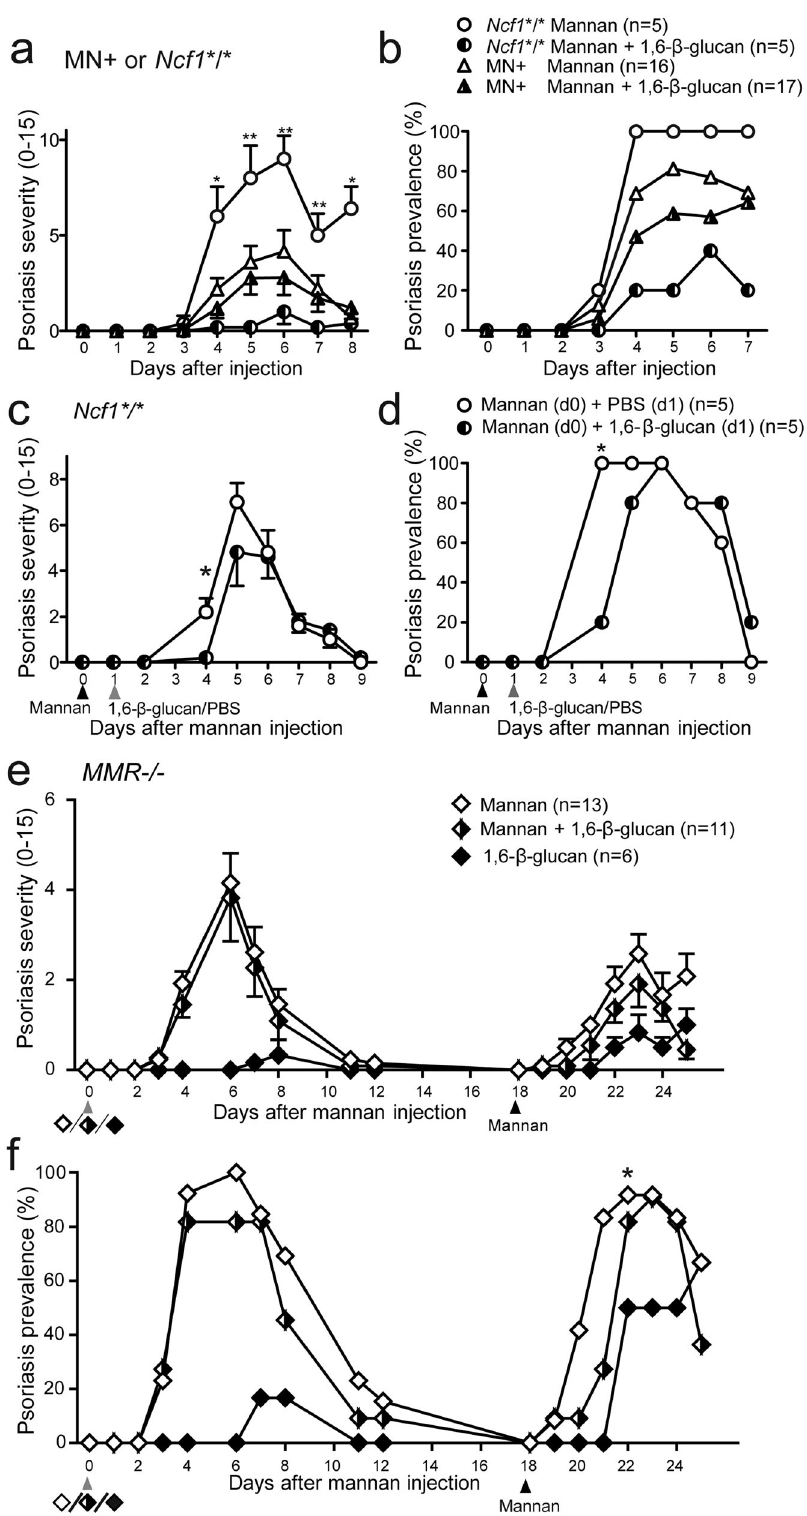
Exclusion was only done if the mice were suffering severe weight loss or exhibited other signs of poor well-being. Experiments were performed with 8 – 25 weeks old mice. Only naïve mice were used, no previous experiments have been performed on them. Polysaccharides . The polysaccharides used in the study are described in Table 1. Mannan (#M7504) and 1,3 – 1,6- β -glucan (#G5011) from Saccharomyces